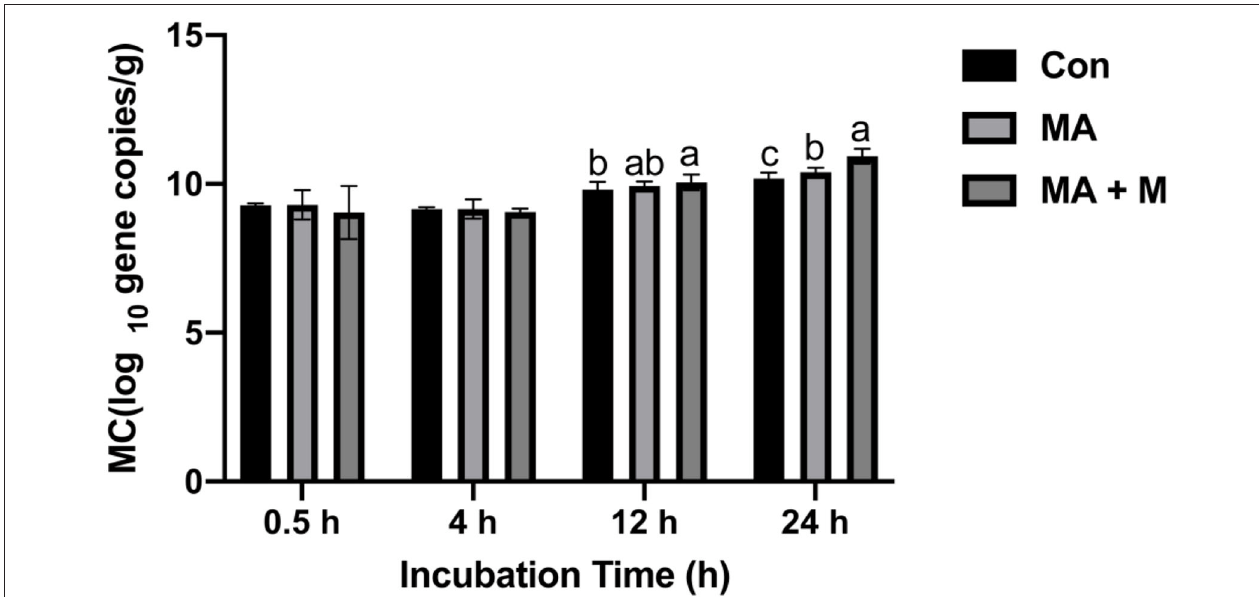
FIGURE 5 | The effect of MA pretreatment on the microbial colonization (MC) of rice straw. Con, no additive, control; MA, added microecological agents; MA + M, a combination of microecological agents and molasses. Different superscript letters a, b, and c indicate significantly different values ( P < 0.05) in different groups and the same or no letters indicate insignificant differences ( P >